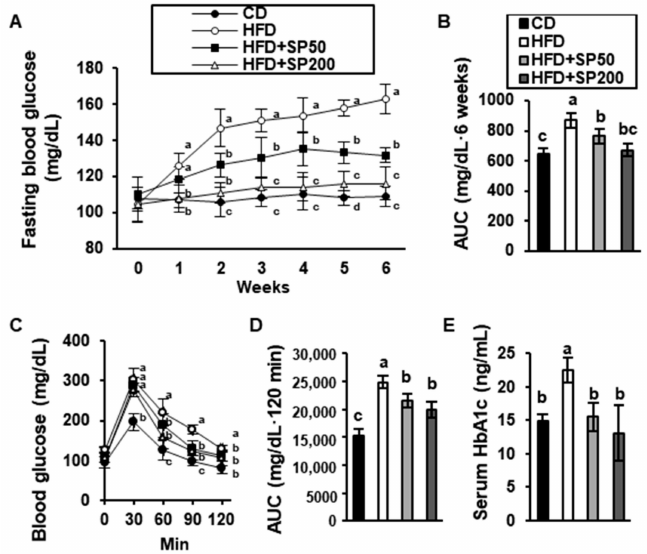
Figure 2. E ff ect of silk peptide on blood glucose in high-fat diet-fed mice. ( A ) Fasting blood glucose was measured and ( B ) the area under the curve (AUC) over time was calculated. ( C ) Oral glucose tolerance testing (OGTT) was performed after 6 weeks and ( D ) its AUC was calculated. ( E ) HbA1c was measured using a commercial kit. Data were analyzed using one-way ANOVA and Duncan’s test. Values with di ff erent letters are significantly di ff erent; p < 0.05 (a > b > c >